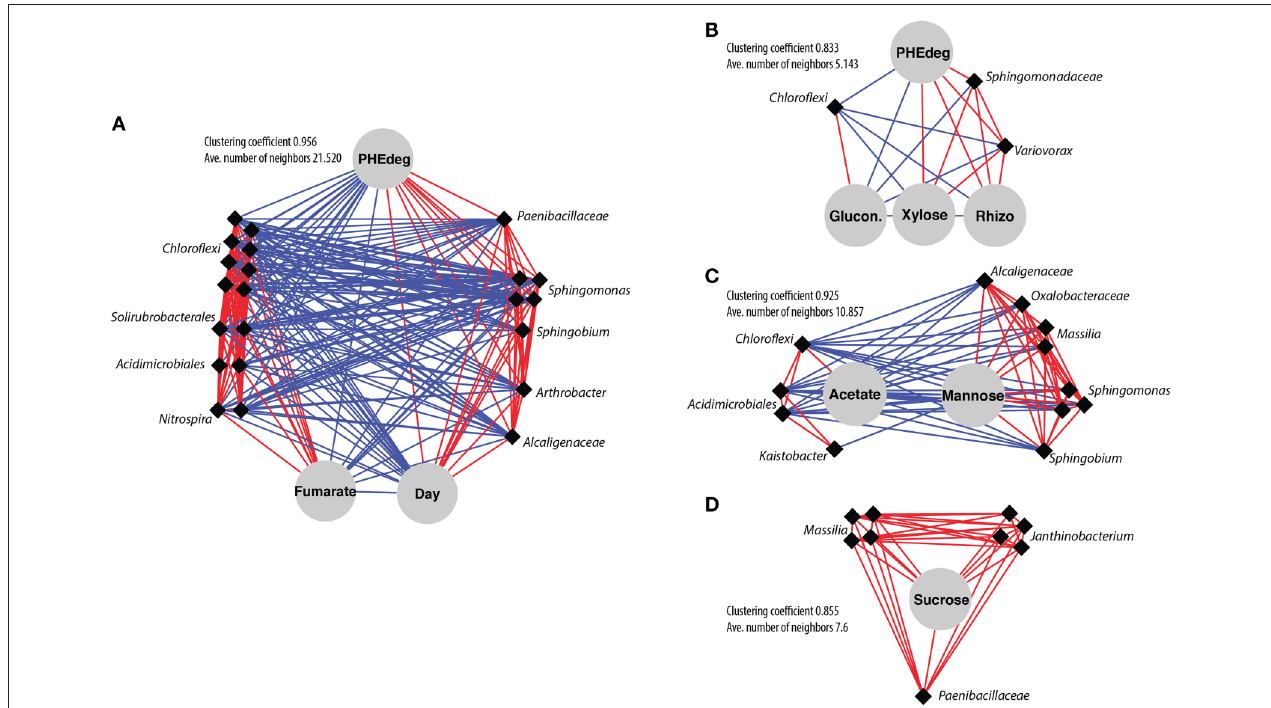
FIGURE 6 | Co-varying networks based on local similarity analysis of abundant OTUs in cDNA libraries ( > 1% in at least one sample) and environmental variables. (A) Sub-network from bare soil centered around phenanthrene degradation. (B–D) Sub-networks from bulk planted soil centered around phenanthrene degradation (B) , mannose (C), and sucrose (D) . Only associations with P < 0.01 were considered significant ( Q < 0.005 and 0.012 for bare and bulk planted soil, respectively). Red and blue line edges represent positive and negative associations, respectively. OTUs are diamonds (with taxonomy) and environmental factors are circles.